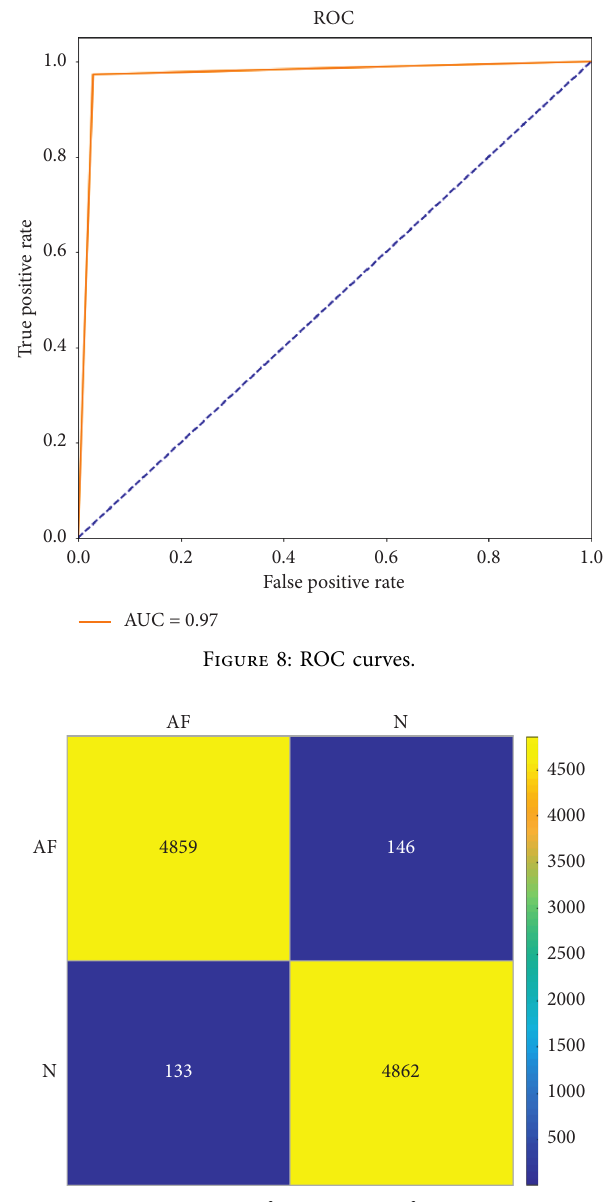
Figure 8: ROC curves.